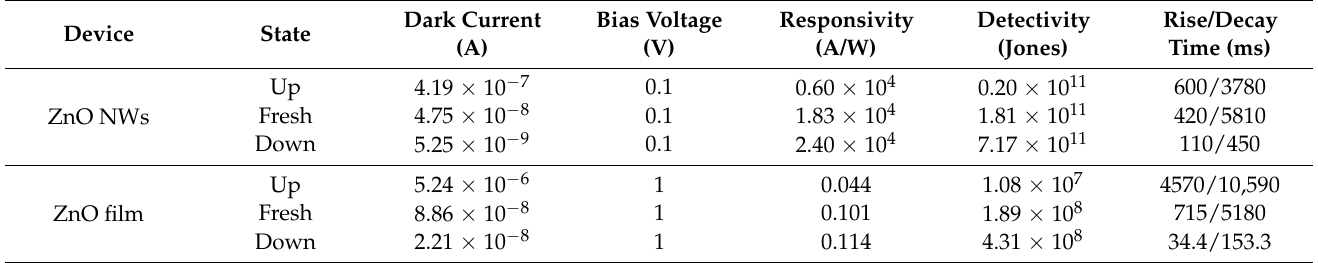
Table 1. Comparison of the main parameters of the devices in three states.